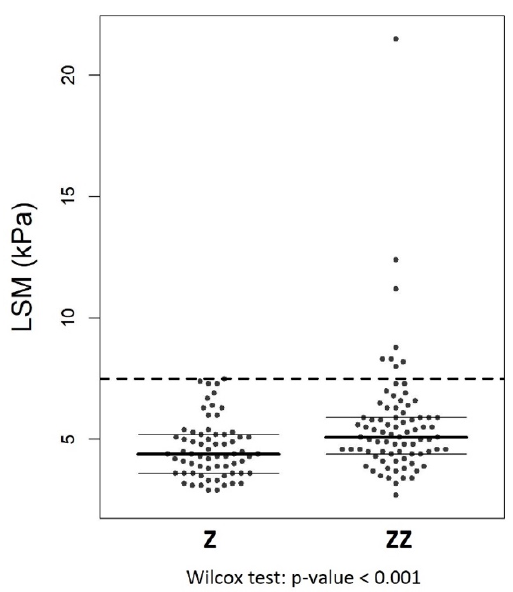
Figure 1. Comparison of mean LSM values by phenotype.